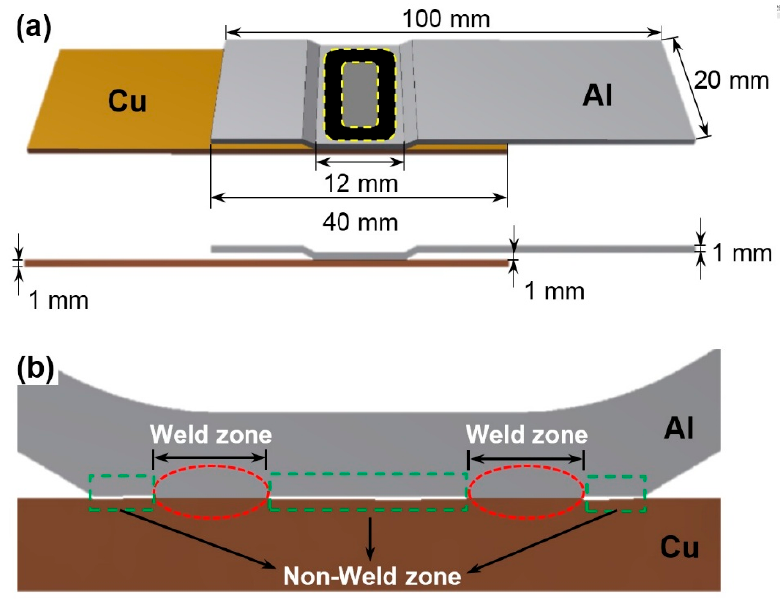
Figure 1. Schematic diagram of an Al-Cu lap shear test sample. ( a ) Welding location and sample dimensions; ( b ) enlarged view of the cross-section of Al-Cu lap joint, showing the weld zones and non-weld zones.